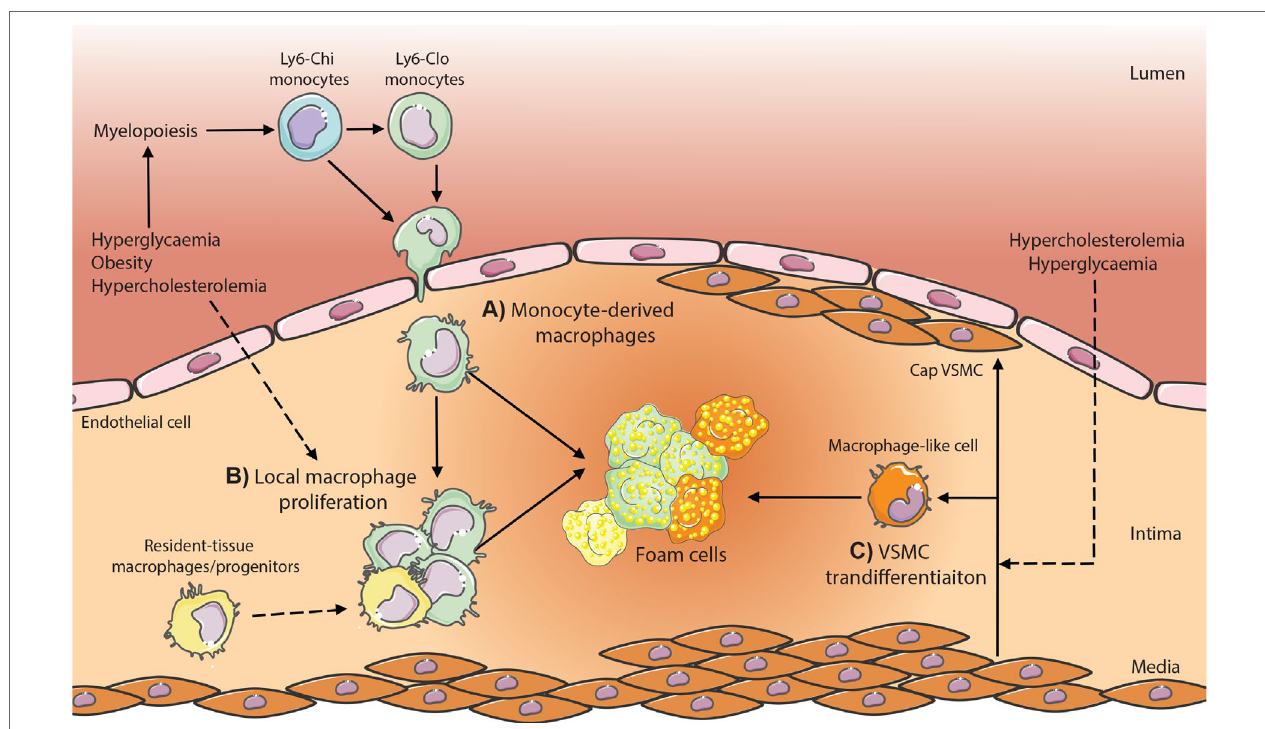
FIGURE 1 | Potential contributing macrophage sources in atherosclerotic plaques in metabolic disease. (A) Monocyte-derived macrophages are produced through enhanced myelopoiesis in response to hyperglycemia, hypercholesterolemia, or obesity-associated adipose inflammation and infiltrate the plaque where lipid-loading triggers transformation into foam cells. (B) Local macrophage proliferation and (C) vascular smooth muscle cell (VSMC) transdifferentiation within the plaque contributes also have the potential to produce foam cells; however, whether metabolic dysregulation (hypercholesteremia, hyperglycemia) modulates these processes is yet to be established in vivo